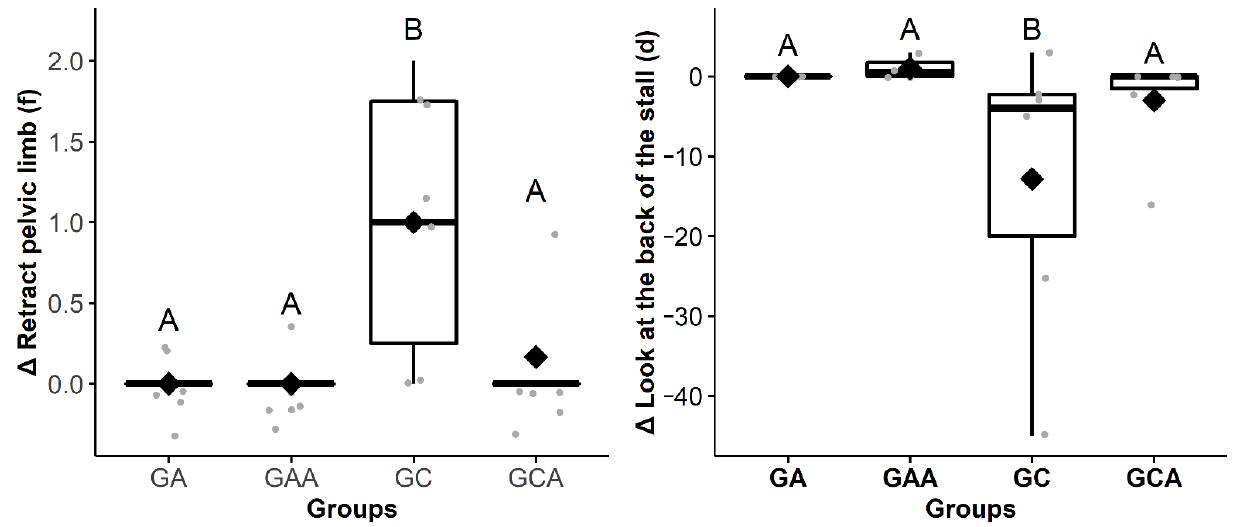
Figure 5. Boxplot ∆ 24 h (09:18 ± 00:28) showing the difference in the frequency (f) or duration (d) of the behaviors retract pelvic limb f and look at the back of the stall d among the groups of horses submitted to anesthesia (GA), anesthesia and analgesia (GAA), preoperative analgesia and anesthesia, orchiectomy, and postoperative analgesia (GC) and preoperative analgesia, anesthesia, and orchiectomy (GCA). The delta (∆) is the subtraction of the behaviors frequency or duration recorded after the anesthesia from those recorded in the mirrored hours before the anesthesia. Different uppercase letters indicate a significant difference over time (A > B). The gray dots represent each horse. Table 4. Summary of the changes in equine behaviors influenced by time of day *, not affected by analgesia or anesthesia and related only with pain in this study ** and described in the literature in different equine pain conditions [1–25,36,41]. The delta ( ∆ ) of behaviors that proportionally increased ( ↑ ), decreased ( ↓ ), or both ( ↑↓ ) exclusively in the GC compared to the other groups in at least one time-point and the behaviors for which the duration or frequency were affected by the time of the day (before anesthesia). The delta ( ∆ ) is the subtraction of the frequency or duration of the behaviors recorded after the anesthesia from those recorded in the mirrored hours before the anesthesia. GC = horses submitted to anesthesia and Table 3. Median and interquartile range (Q1; Q3) of the behavior duration of 24 horses recorded 24 h before anesthesia for orchiectomy with postoperative analgesia; d indicates behaviors assessed as duration and f as all groups together. Different lowercase letters indicate significant difference over time (a > b > c). AR = after the end of the anesthetic recovery (to investigate the effect of the recording time, the frequency, and duration of behaviors were analyzed on the day before anesthesia combining all groups, because all horses were under the same conditions and had not undergone any procedure yet).